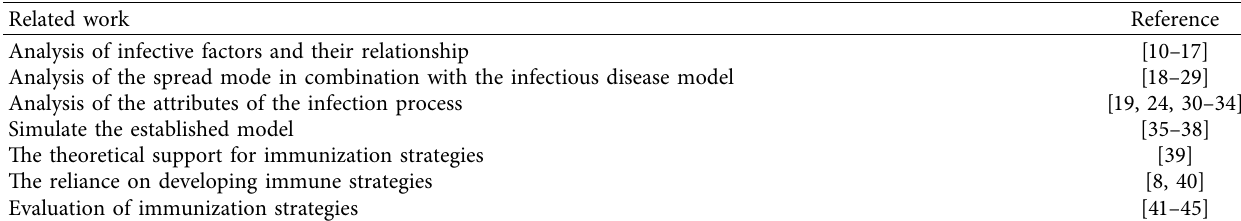
Figure 2: The process of screening articles: at the beginning, we retrieved 1752 papers on specific topics, then deleted 388 papers due to repetition, unqualified, or unavailable, and next eliminated 928 less relevant papers through abstract or full-text reading. Finally, we obtained 149 papers for the study. Table 1: The work done on infectious diseases using the BA scale-free network: in the related work column, the research studies performed by researchers using the BA scale-free network are shown, and in the reference column is the relevant literature of the corresponding